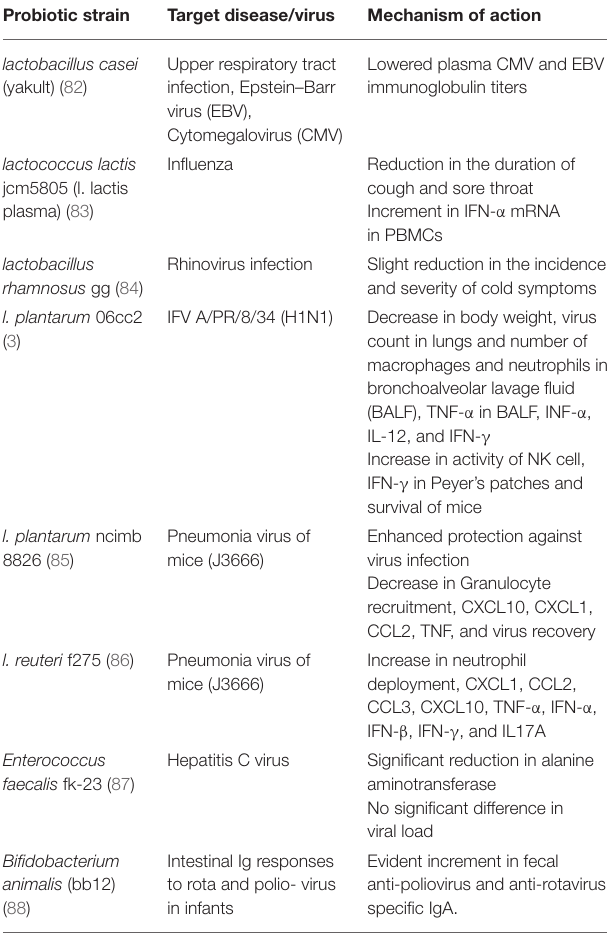
TABLE 4 | Effect of different probiotic strains on